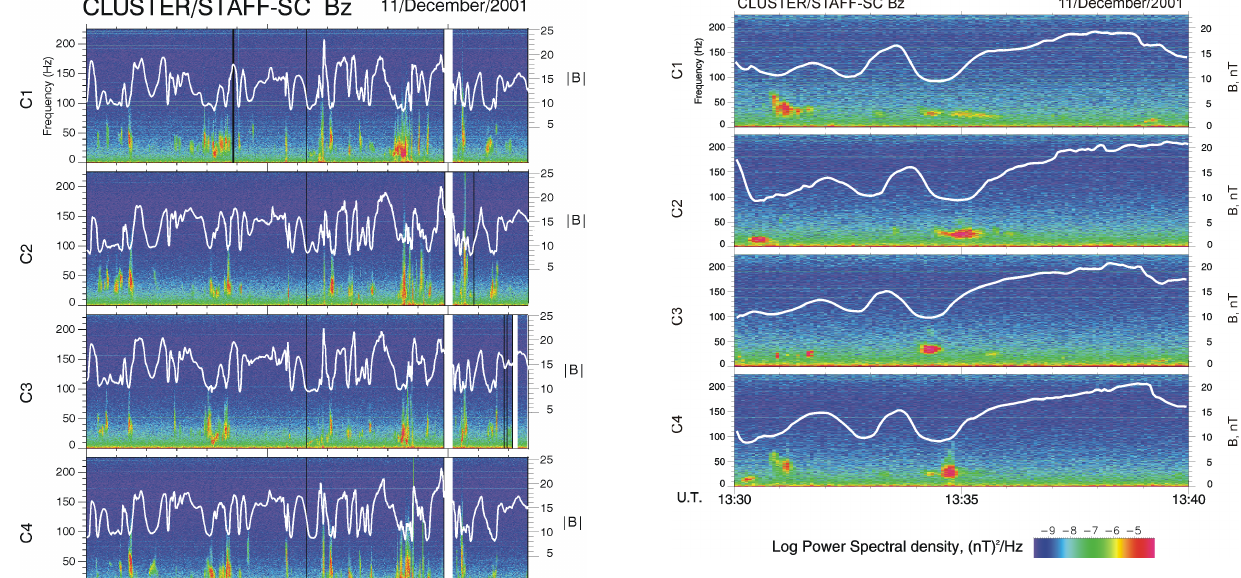
Fig. 2. Close-up of the wave intensity on different spacecraft cross- ing the same magnetic field depleted